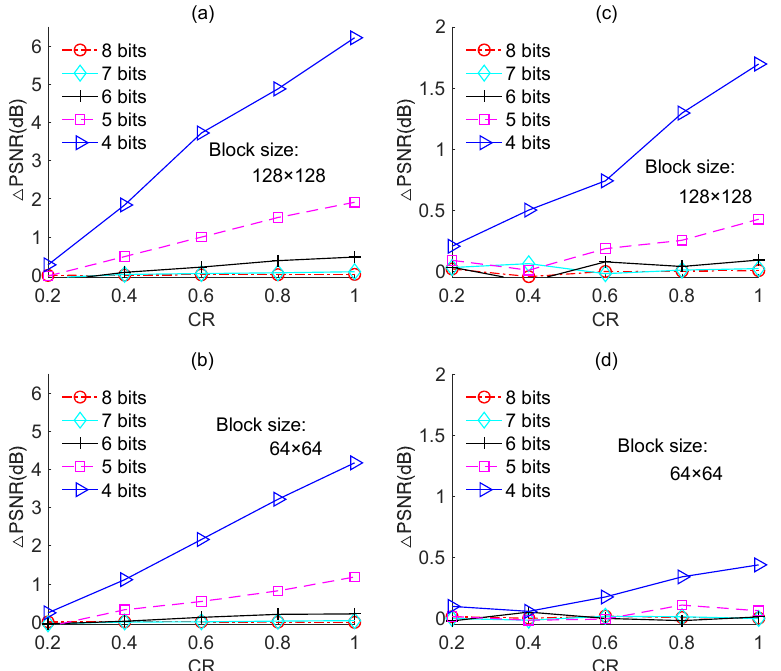
Figure 12. PSNR losses of the quantized BCS with different resolutions of ADC for the “Foreman” image. ( a , b ) are based on Zadoff–Chu measurement matrix; ( c , d ) are based on real-valued Hadamard measurement matrix.